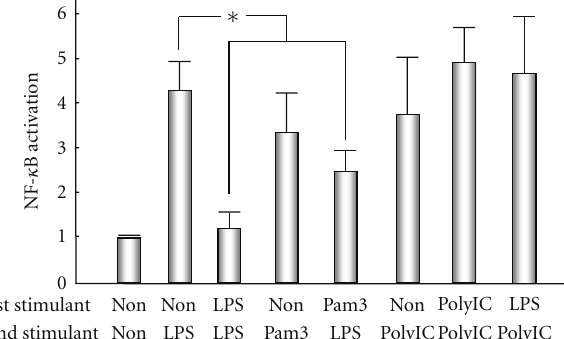
Figure 3: Induction of tolerance in cultured human biliary epithe- lial cells (BECs). BECs are pretreated with lipopolysaccharide (LPS, TLR4 ligand) or Pam 3 CSK 4 (Pam3, TLR1/2 ligand) for 24 hours and subjected to another LPS challenge. Pretreatment with LPS and Pam 3 CSK 4 significantly decreases NF- κ B activity in response to a subsequent LPS challenge. In contrast, the pretreatment with poly (I:C) (TLR3 ligand) or LPS does not inhibit NF- κ B’s activation in response to a subsequent poly (I:C) challenge ( ∗ < . 05).